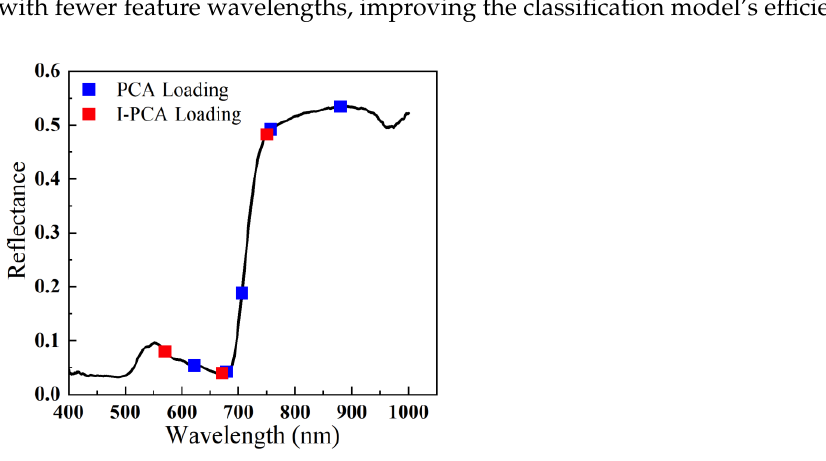
Figure 7. Feature wavelengths selected by conventional PCA loading and improved PCA loading.